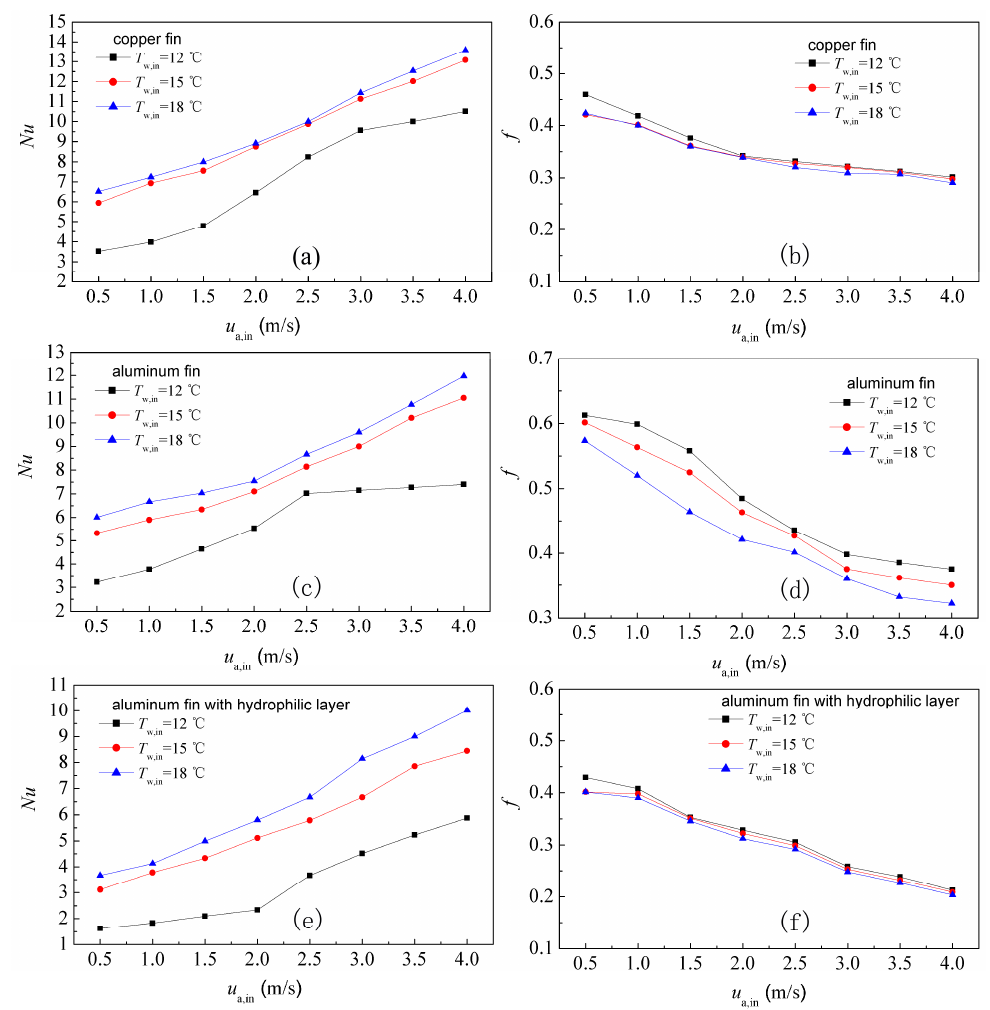
Figure 10. Effect of T w,in on Nu and f of three different fin materials: ( a , c , e ) Nu , ( b , d , f ) f .